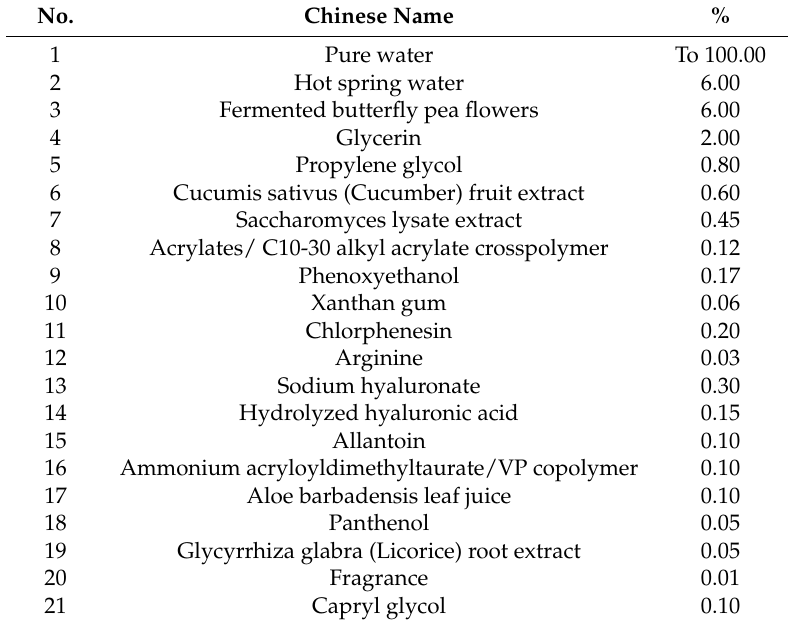
Table 5. Butterfly pea flower brightening mask containing hyaluronic acid and hot spring water. No. Chinese Name % 1 Pure water To